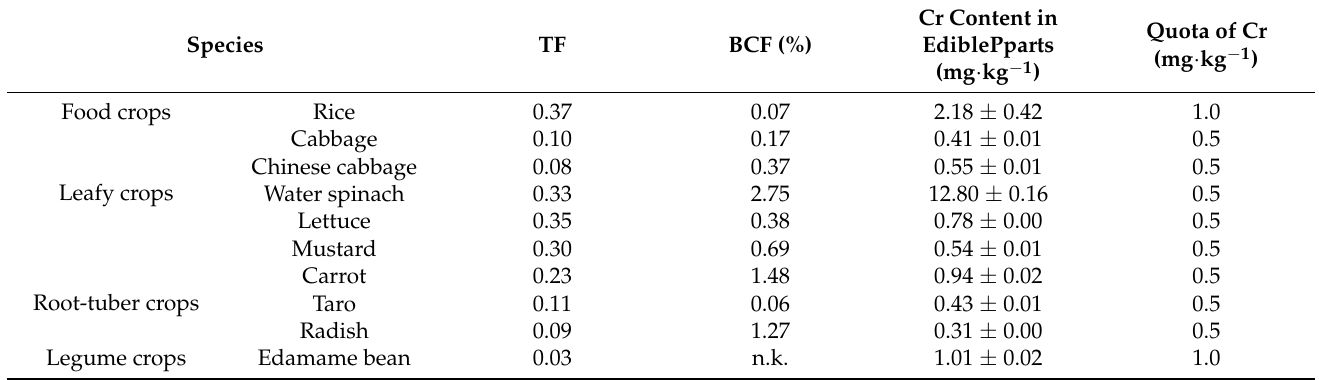
Table 4. Cr content and bioaccumulation coefficient of the edible part of agricultural products.